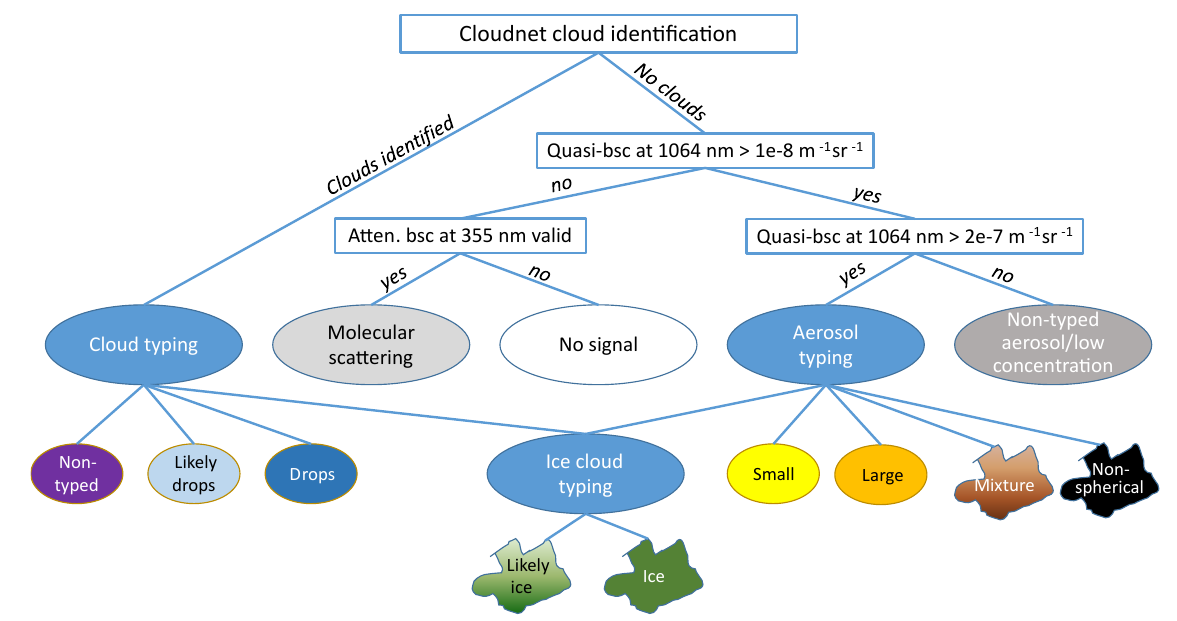
Figure 7. Schematic illustration of the typing procedure. Details in text and Table 1. Table 1. Overview of particle typing. Criteria for the feature classes are given. Quasi-particle-backscatter coefficient values are given in m − 1 sr − 1